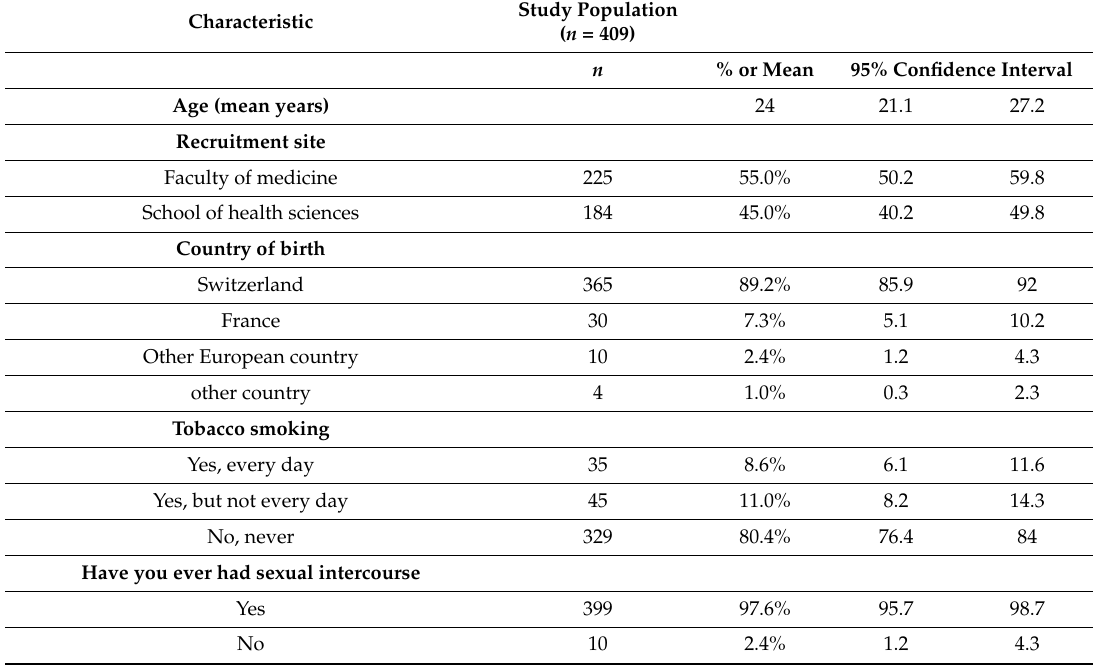
Table 1. Study participants socio-characteristics. HPV—human